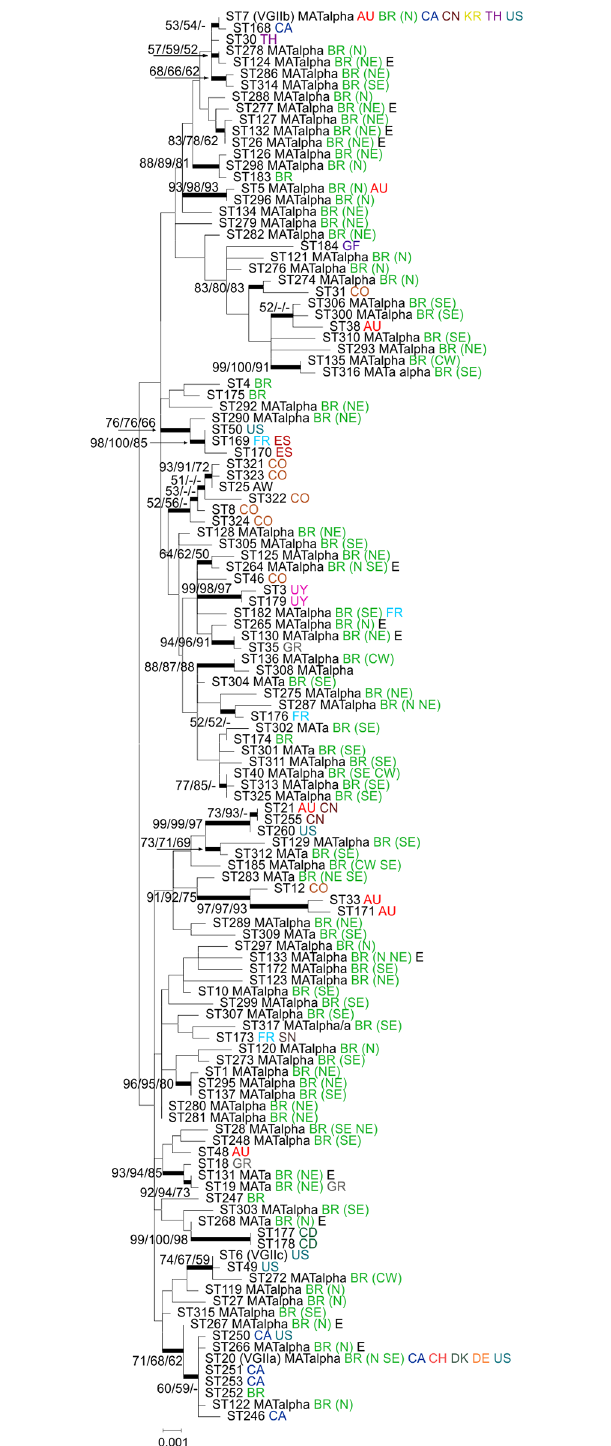
Fig 1. Phylogenetic analysis of Brazilian Cryptococcus gattii VGII isolates inferred by maximum likelihood (ML), neighbour-joining (NJ), and maximum parsimony (MP) methods using the concatenated data set of the seven MLST genes. All Brazilian Sequence types (81) from this study and 42 additional Sequence types representing all previously published VGII sequence types maintained in the MLST database (mlst.mycologylab.org) were included in the analysis. The tree with the highest log